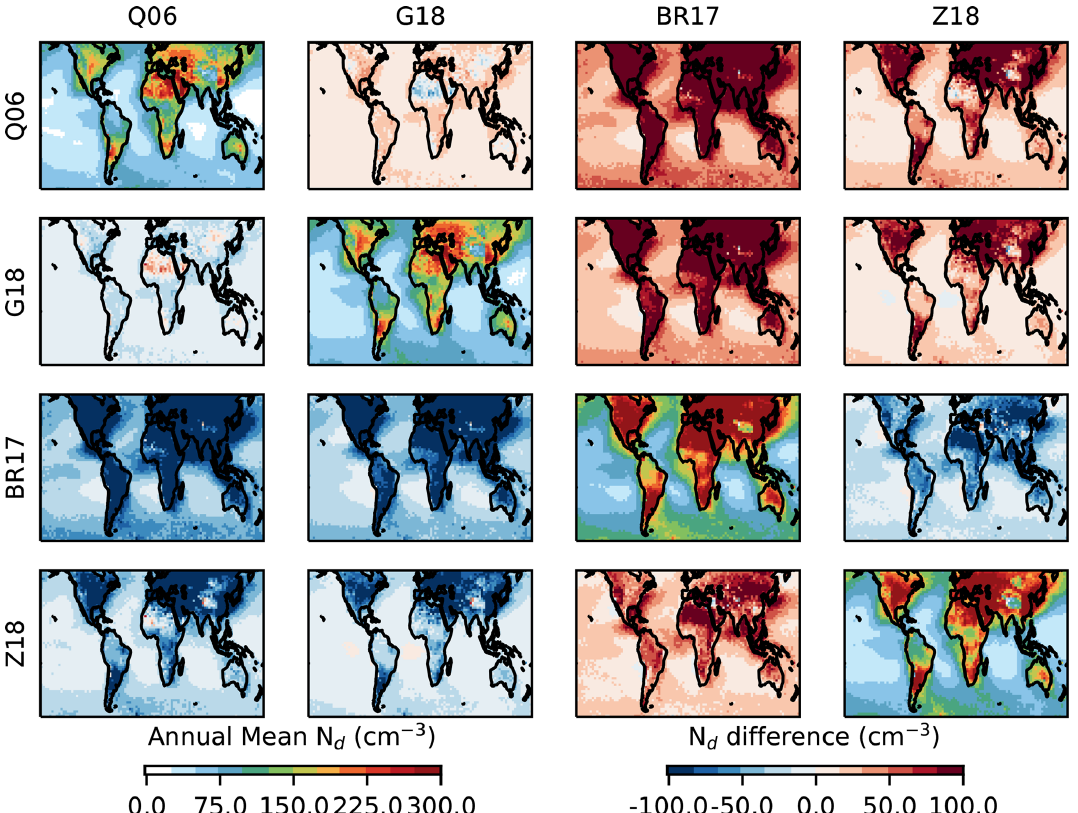
Figure 7. MODIS N d climatology (2011–2020) for different sampling strategy. The diagonal is the annual mean N d for each strategy, while the off-diagonal plots show the difference (e.g. the top right is Z18 − Q06).